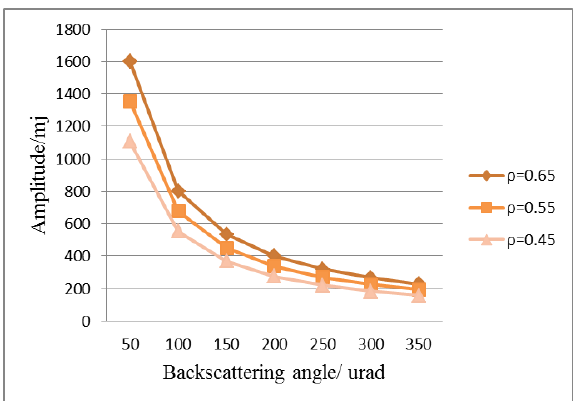
Figure 5. Amplitudes of different reflectivity and backscattering angles